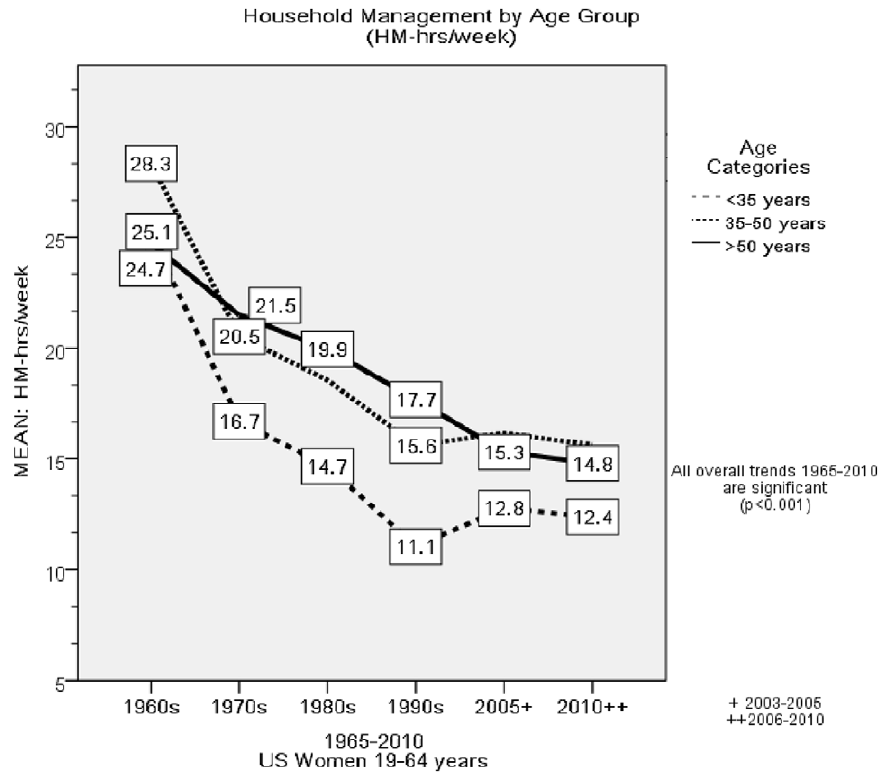
Figure 2. Household Management Hours per Week by Age Group. This figure depicts the decade to decade trends in the change in Household Management Hours per Week (HM-hr/week) by age